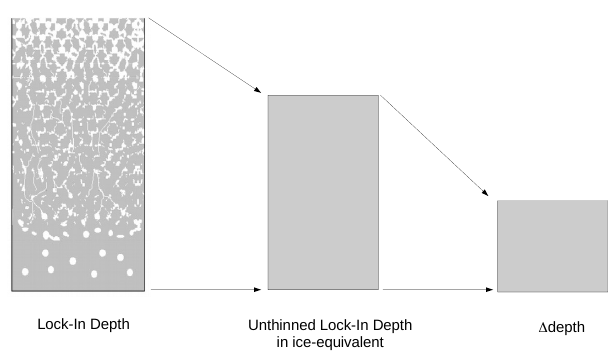
Figure 2. Scheme of different representations of a firn column. (Left) When the firn column is at surface, its height is equal to the lock-in depth. (Middle) If one virtually converts the firn col- umn into cumulated ice-equivalent accumulations, one gets the un- thinned lock-in depth in ice equivalent (ULIDIE). (Right) When the firn column is buried down into the ice sheet and encounters vertical thinning, its height decreases to (cid:49)